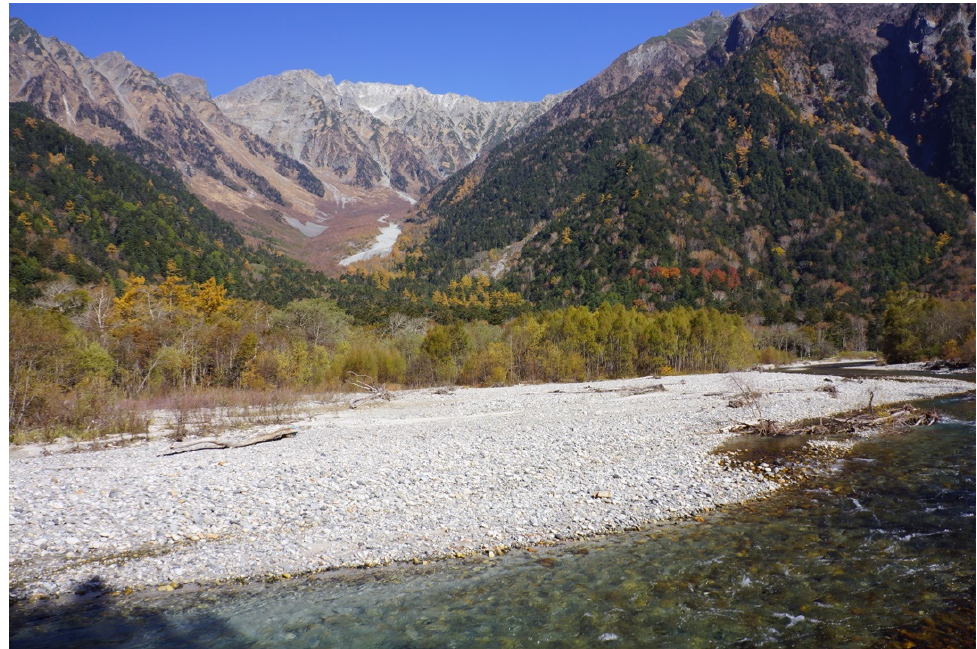
Figure 2. Kamikochi, with Azusa River in the foreground, Salix arbutifolia growing on the gravelly riverbed, and the Hotaka Range in the background. Photo by author.